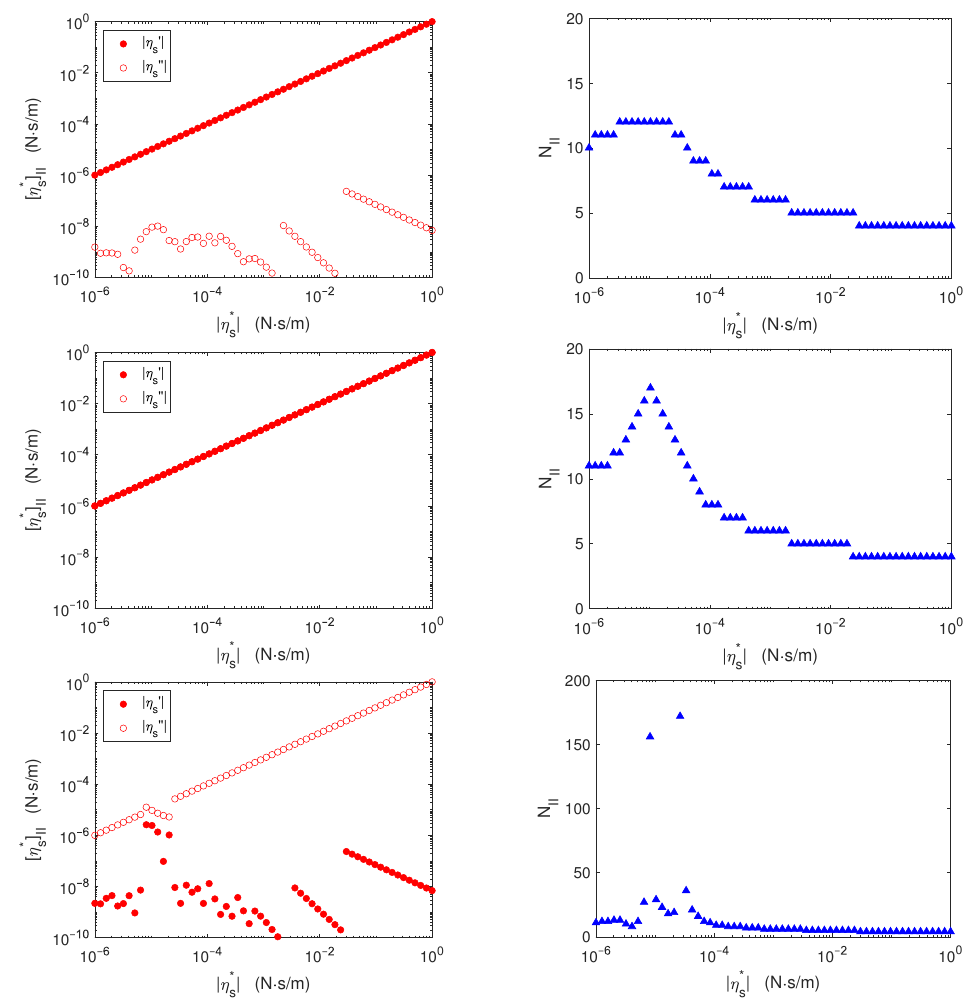
Figure 10. Real (solid circles) and imaginary (open circles) parts of the interfacial shear viscosity (left column) and number of iterations (triangles) until convergence (right column) as a function of the interfacial shear viscosity modulus, | η ∗ s | at a frequency f = 0.5 Hz. Upper row: Purely viscous interface ( η (cid:48)(cid:48) s = 0). Middle row: Viscoelastic interface ( η (cid:48) s = η (cid:48)(cid:48) s ). Bottom row: Purely elastic interface ( η (cid:48) s =